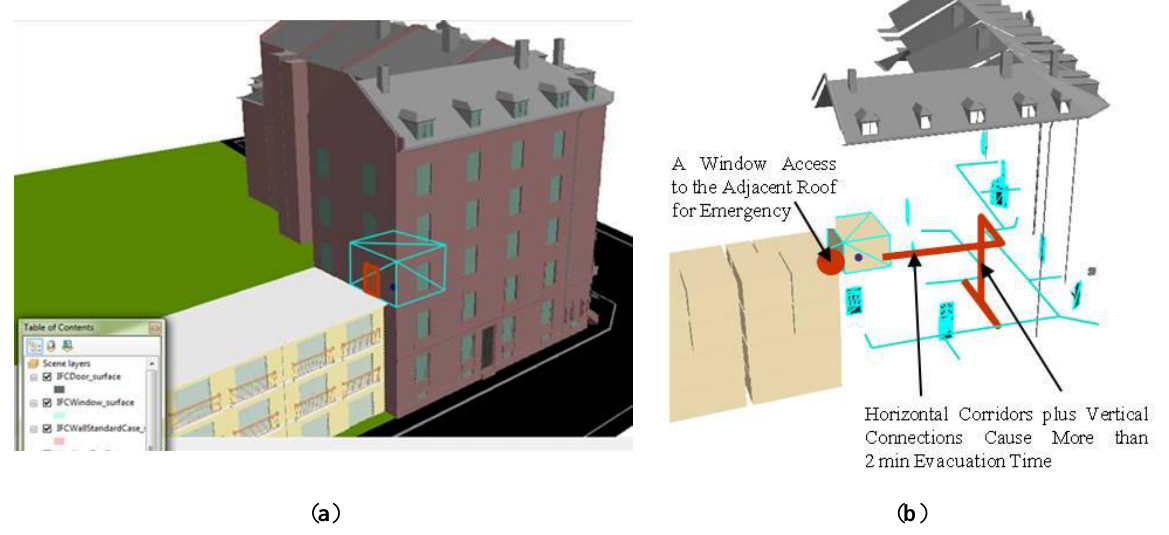
Figure 13. ( a ) A space to be tested versus the evacuation plan. ( b ) Considering the roof of adjacent CityGML building for the evacuation